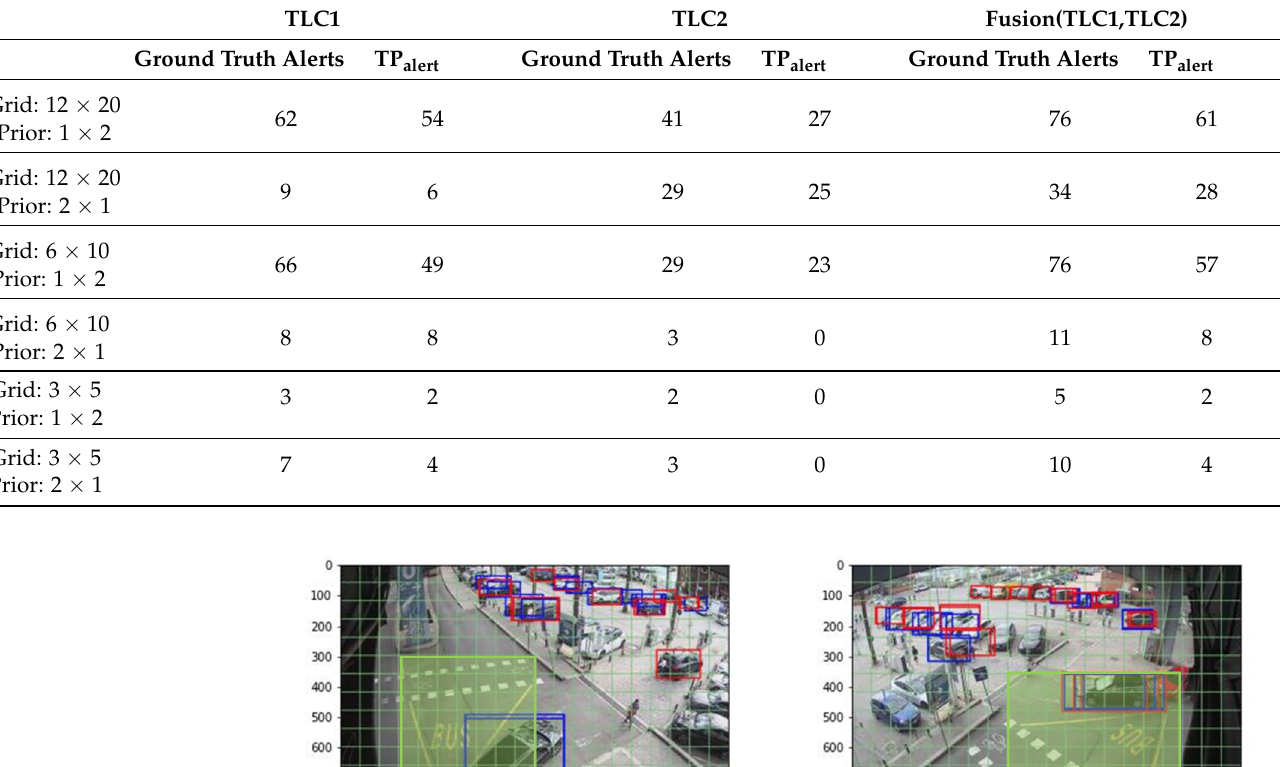
Table 4. Number of ground truth alerts and TP alert for each grid and prior using single camera processing ( TLC1 , TLC2 ) and data fusion of both cameras ( fusion(TLC1,TLC2) ). TLC1 TLC2 Fusion(TLC1,TLC2)